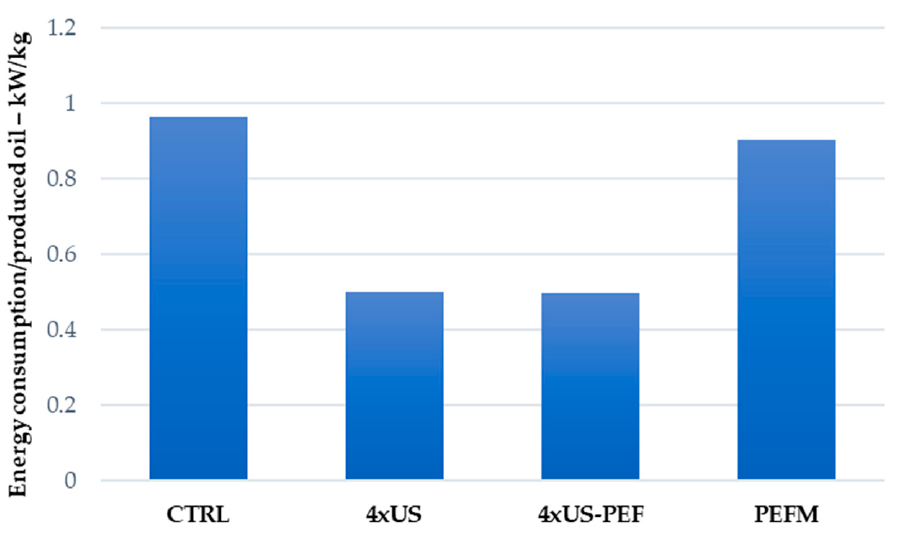
Figure 10. Energy consumption in function of oil yield. Table 4. Industrial trials: results summary.